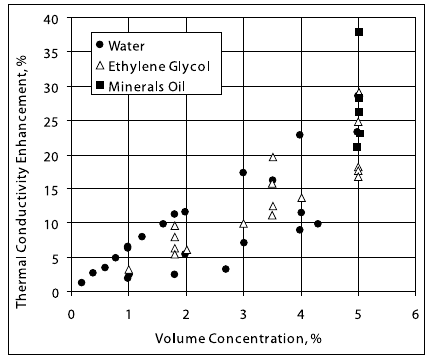
Fig. 2 Effect of temperature on the thermal conductivity enhancement: data source see the legend.